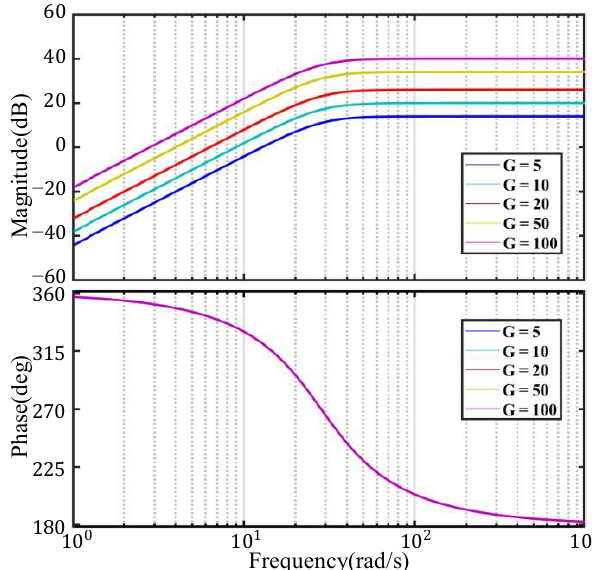
Figure 4. Frequency characteristic curves under different sensitivities.